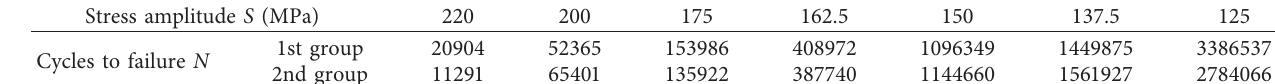
Table 1: Fatigue test results.